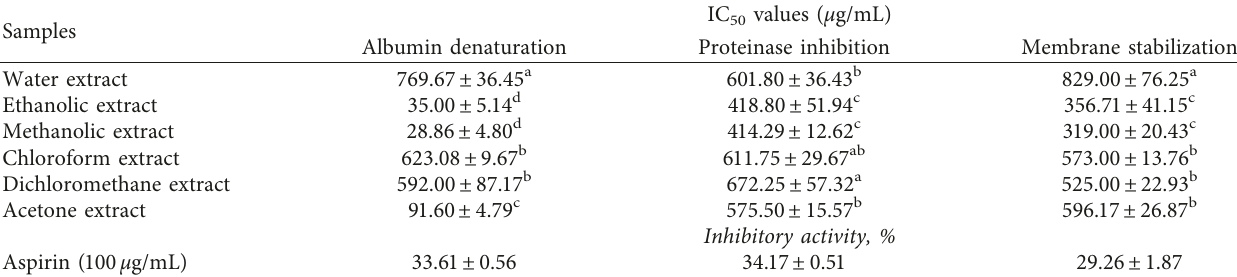
Table 3: In vitro anti-inflammatory activity of different S. buxifolia extracts.